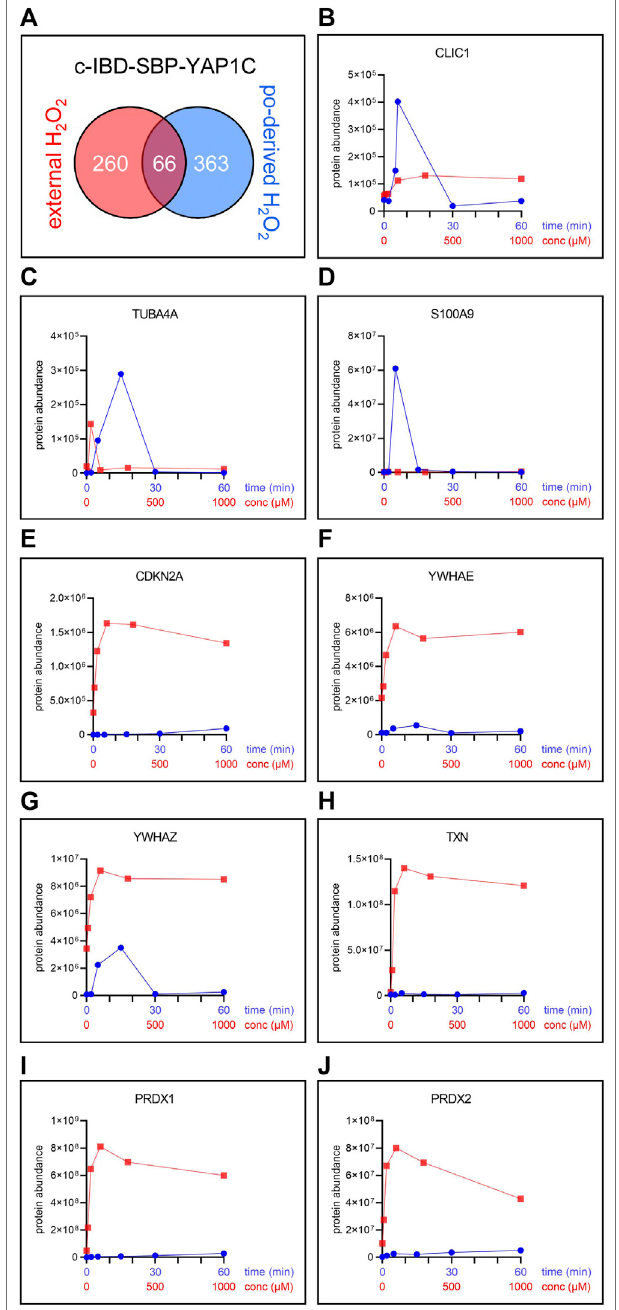
FIGURE 8 | The pool and sulfenylation pro fi les of c-IBD-SBP-YAP1C interactors differ depending on the H 2 O 2 source. (A) Venn diagram showing the number and overlap of signi fi cantly enriched interactors of c-IBD-SBP- YAP1C upon treatment of po-DD-DAO Flp-In T-REx 293 cells (i) for any time period (2, 5, 15, 30, or 60 min) with 10 mM D-Ala ( Supplementary Table S3 ) or (ii) with any concentration (10, 30, 100, 300, or 1,000 µM) of external H 2 O 2 for 10 min ( Supplementary Table S6 ). (B – J) Sulfenylation pro fi les of a selected set of c-IBD-SBP-YAP1C interactors upon peroxisomal H 2 O 2 production (time curve; in blue) or addition of external H 2 O 2 for 10 min (concentration curve; in red). Protein abundances are based on peptides that were commonly retrieved in the experiments